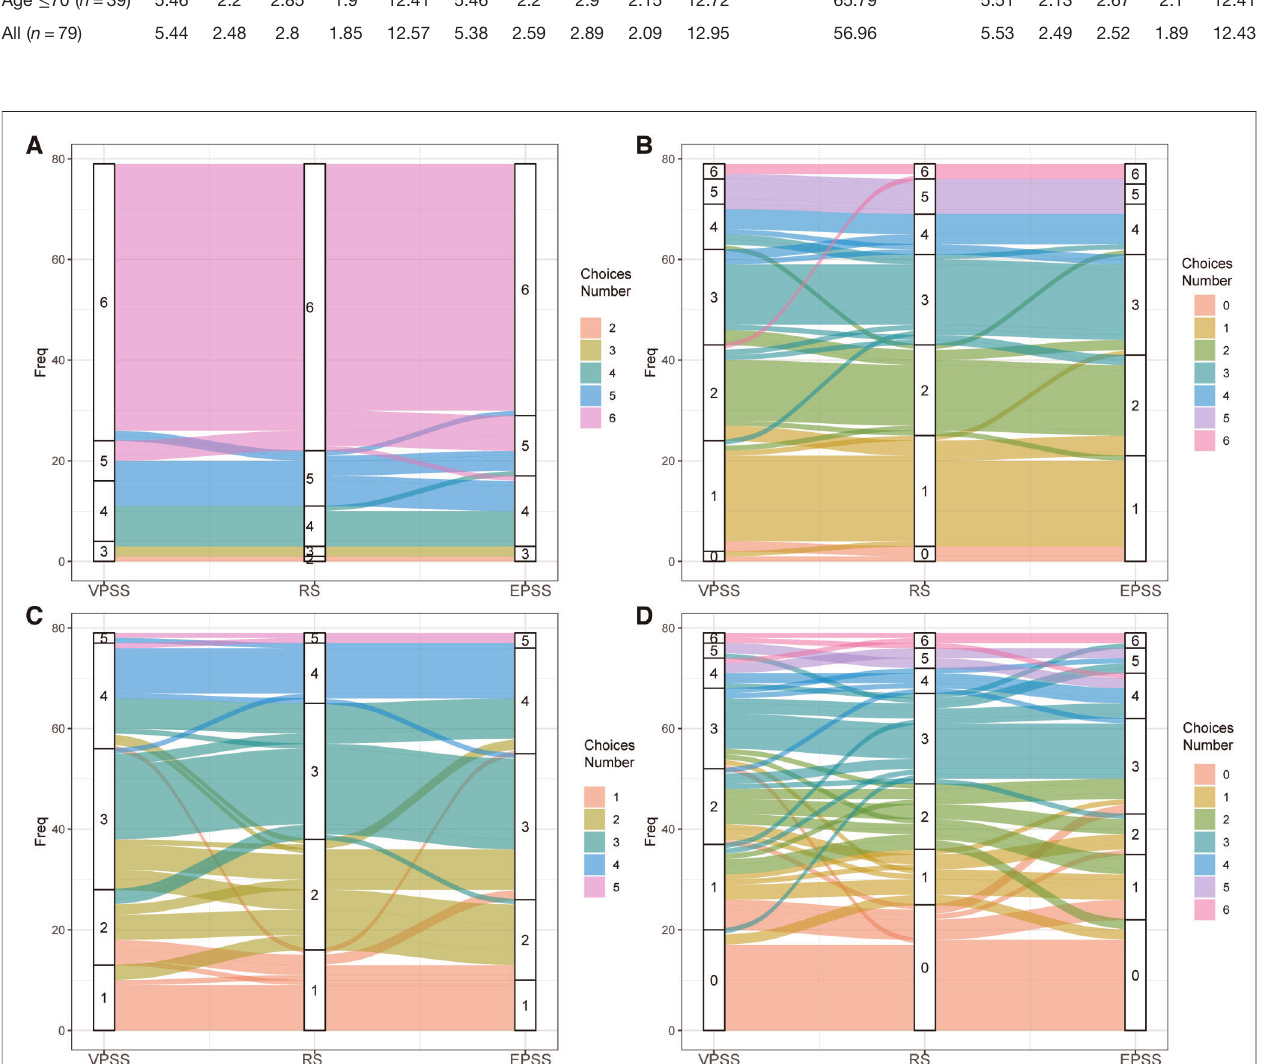
FIGURE 2 | Sankey diagram showing the different choices patients made among VPSS, RS, and EPSS in ( A ) question 1, ( B ) question 2, ( C ) question 3, and ( D ) question 4. By comparing the fl ows on the two sides, we could see which scale performed better. No obvious differences were seen: ( A ) both VPSS and EPSS sides were very neat and ( D ) both sides were chaotic. In ( B , C ), EPSS performed better with less and thinner chaos fl